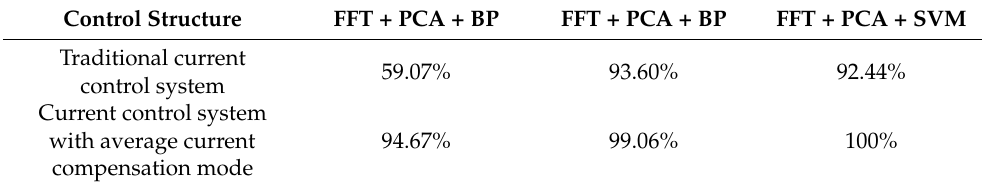
Table 2. Three-phase current sensor fault types.